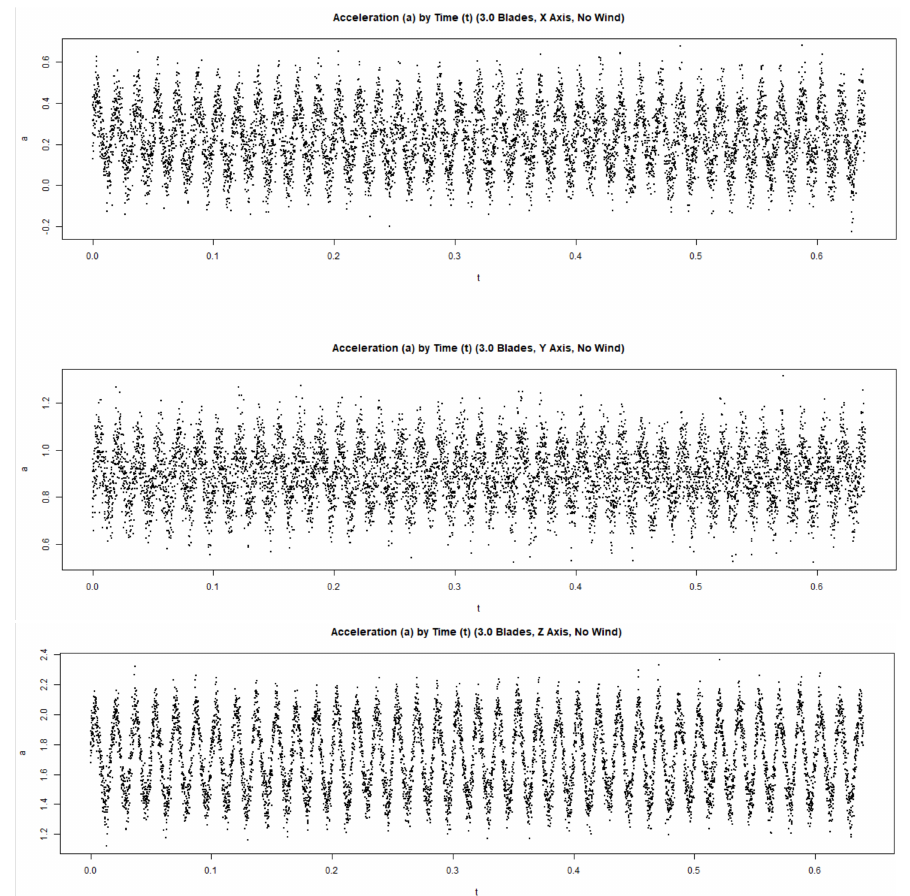
Figure 2. Acceleration signals recorded for the full (normal) 3.0-blade